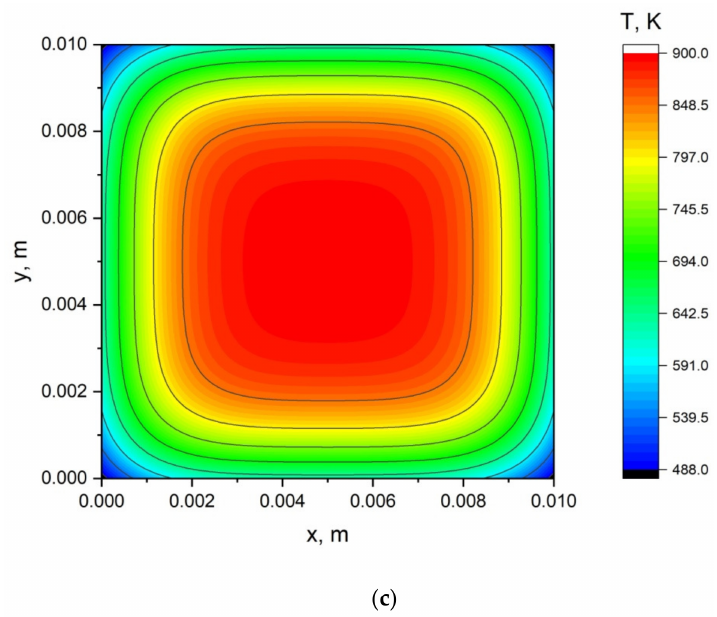
Figure 4. Temperature distribution in the firebrand at the moment of time 10 s: ( a ) transverse dimension 10 cm; ( b ) transverse dimension 5 cm; ( c ) transverse dimension 1 cm.